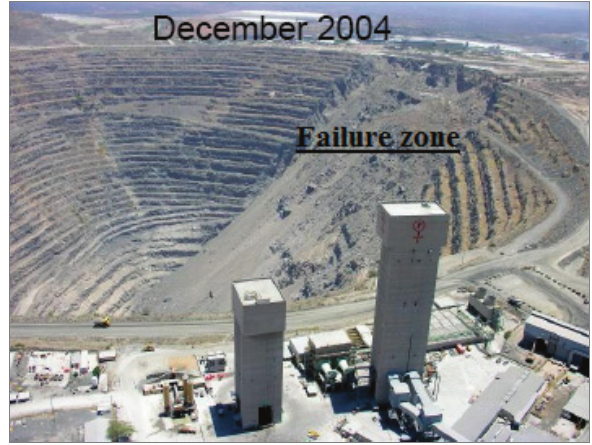
Fig. 4. Failure at Palabora mine (modified after Ngidi and Boshoff [18])